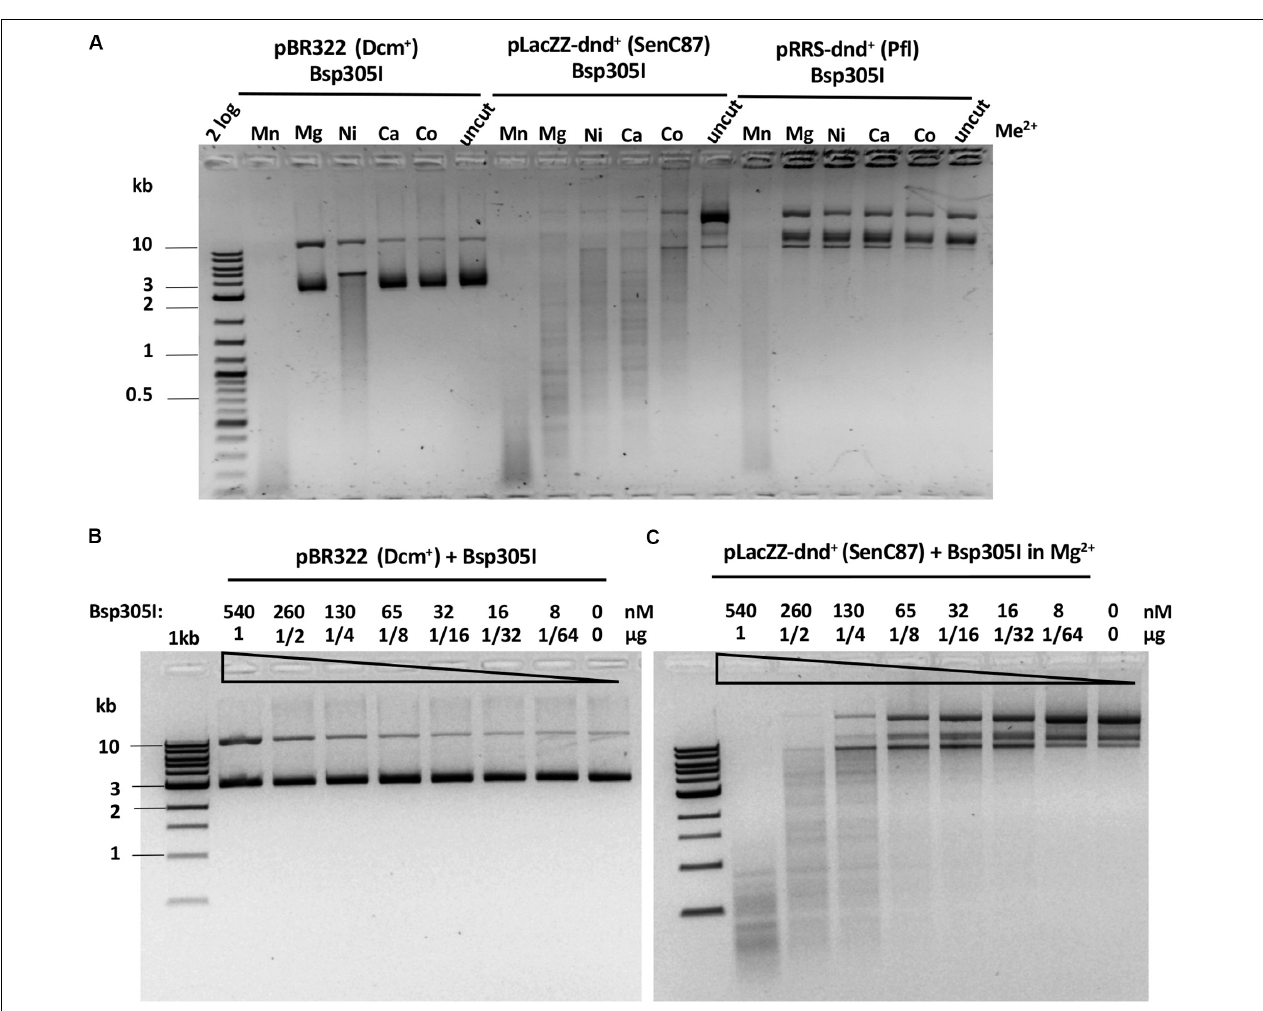
FIGURE 6 | Bsp305I divalent cation requirement and restriction activity in Mg 2 + buffer on methylated and phosphorothioated plasmids. (A) Bsp305I activity in a medium salt buffer supplemented with different divalent cations. (B) Bsp305I activity assay on pBR322 Dcm + plasmid in Mg 2 + . (C) Bsp305I activity assay on dnd + plasmid (SenC87) in Mg 2 +